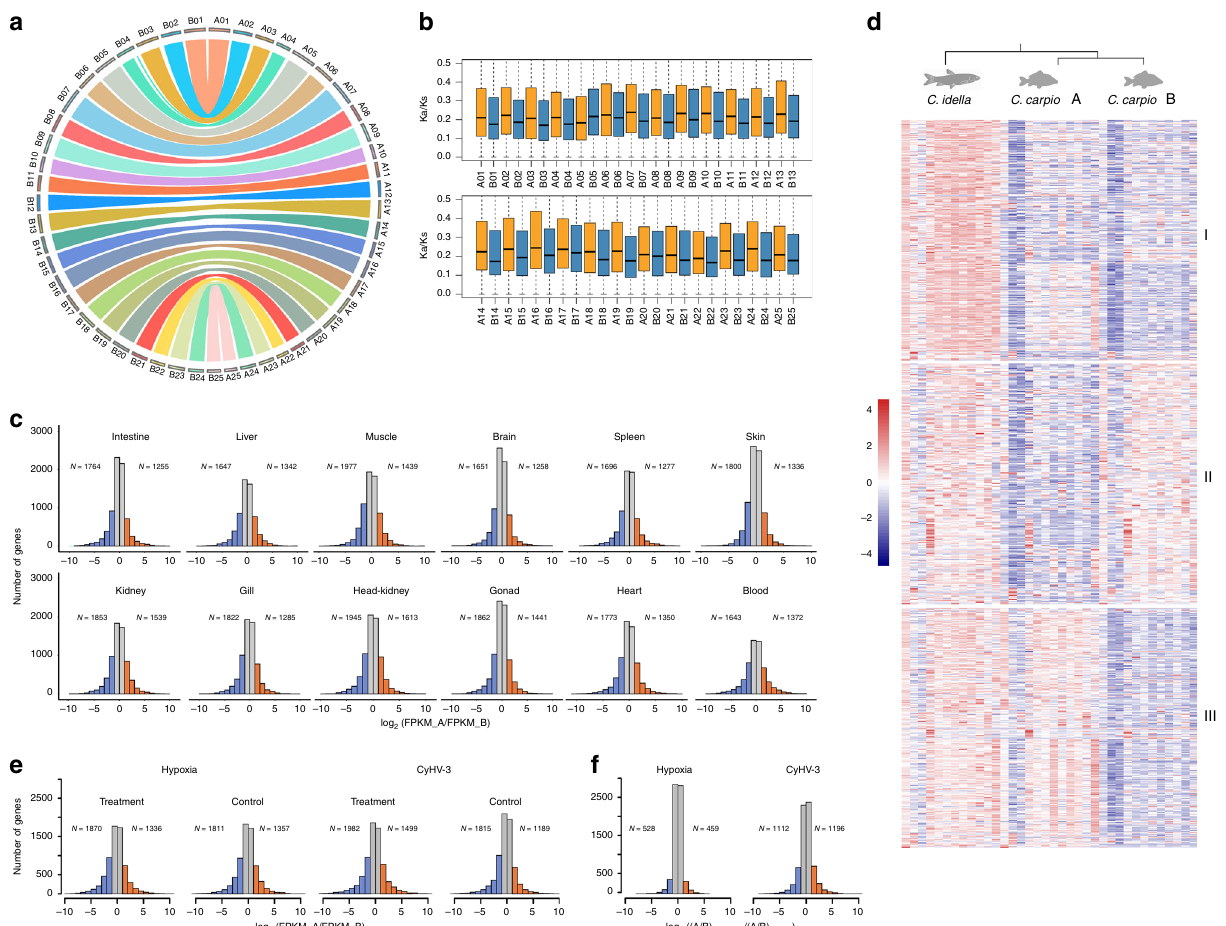
Fig. 3 Asymmetrical homoeologous gene expression in C. carpio . a Circos plot distribution of homoeologous gene pairs in 25 chromosome pairs across subgenomes A and B. b Boxplot of the Ka/Ks ratio distribution of protein-coding genes in 50 chromosomes of C. carpio . Orange and blue boxplots indicate that the chromosomes belong to subgenomes A and B, respectively. c Histograms of the genome-wide expression of homoeologous genes among the indicated tissues of C. carpio . Log 2 (FPKM_A/FPKM_B) indicates the degree of expression difference of homoeologous gene pairs. N values indicate the number of dominant genes in subgenomes A and B. d Heatmaps of three divergently expressed triplet clusters (each triplet includes two homoeologous genes of C. carpio and their orthologue of C. idella ), indicate potential subfunctionalization and neofunctionalization in the allotetraploid genome of C. carpio . The orders of 12 tissues in both C. idella and C. carpio are the same as 3c. e Histograms of the genome-wide expression divergence of homoeologous genes of C. carpio in stress treatments and controls. N values indicate the number of dominant genes in subgenomes A and B, respectively. f Histogram of the ratio of homoeologous expression divergence in the stress treatment and controls [(A/B) treatment /(A/B) control ], which indicates accelerated